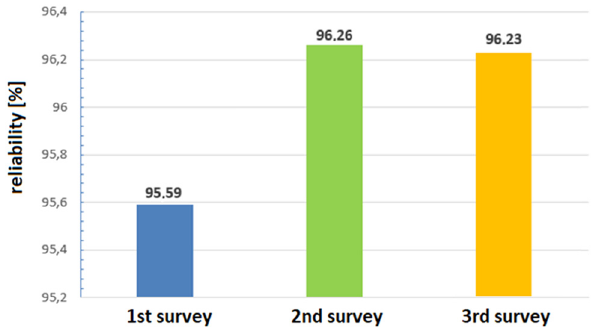
Figure 10: The reliability of the speedometer.